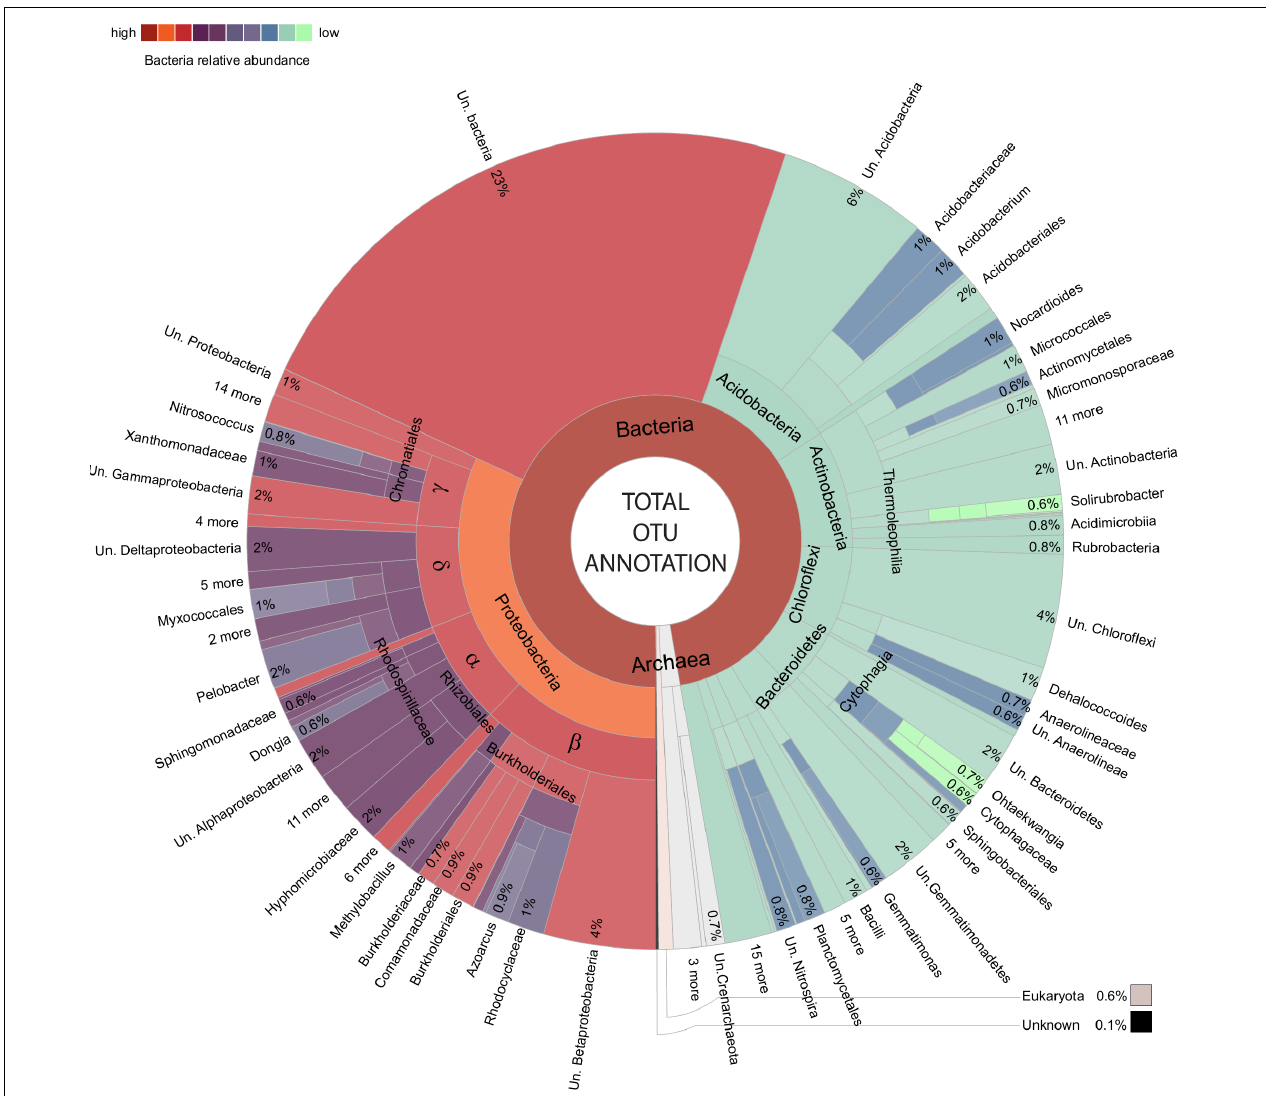
FIGURE 3 | Total amplified community makeup. Krona chart (Ondov et al., 2011) presenting an overview of